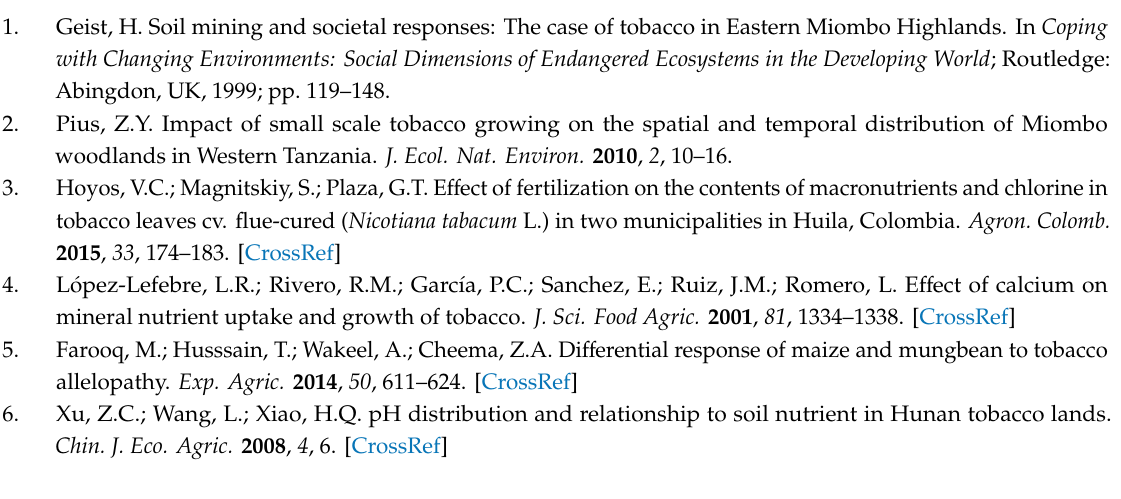
Table S1: Soil properties of the Sikonge site, Table S2: Soil properties of the Tabora site, Table S3: Soil properties of the Urambo site, Table S4: Leaf nicotine and tobacco leaf yield from three sites (Sikonge, Tabora, and Urambo), Table S5: Leaf nicotine concentrations and tobacco leaf yield of the Sikonge site, Table S6: Leaf nicotine concentrations and tobacco leaf yield of the Tabora site, Table S7: Leaf nicotine concentrations and tobacco leaf yield of the Urambo